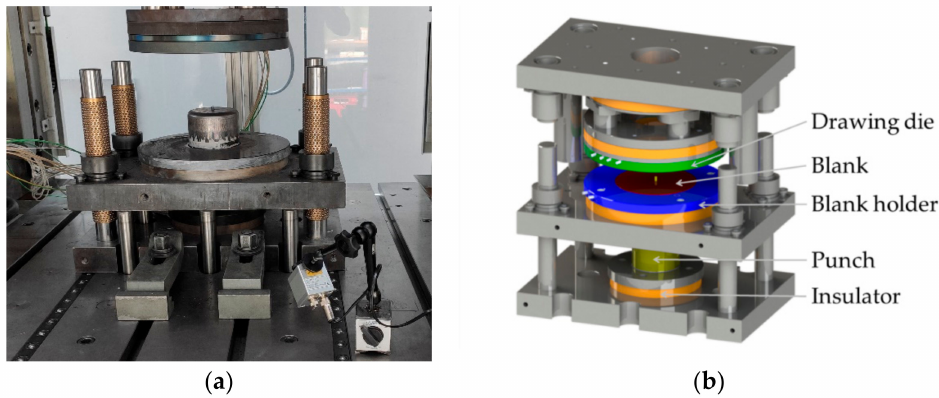
Figure 2. Deep drawing tool mounted in press ( a ) and CAD design of the deep drawing tool ( b ).